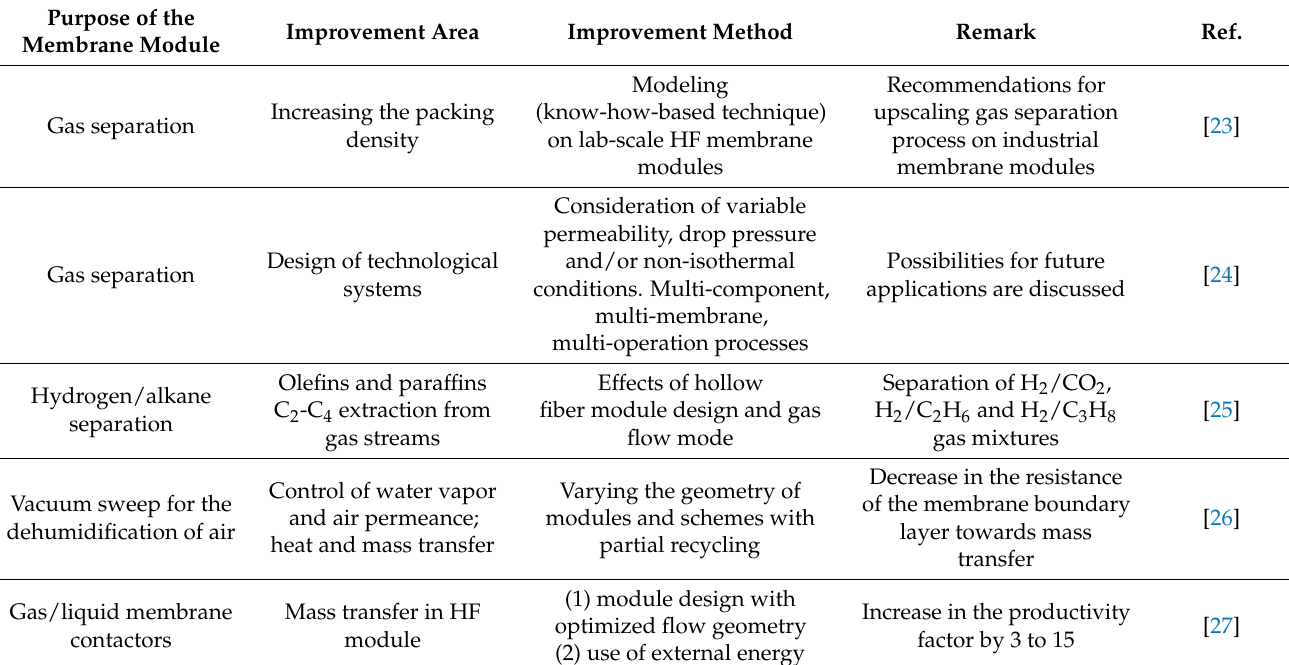
Table 1. Main trends in improving the efficiency of HF membrane